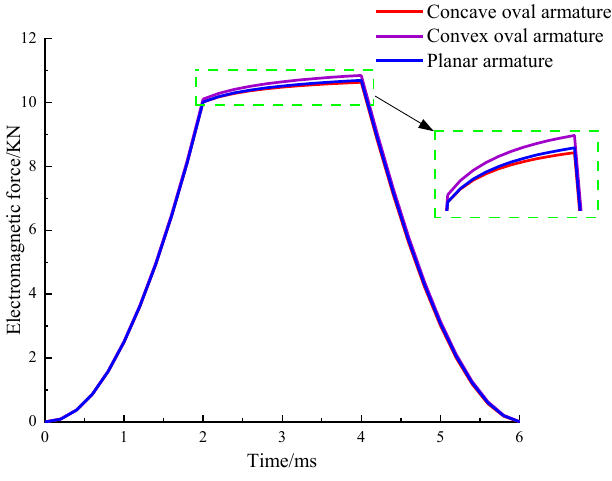
Figure 6. Electromagnetic thrust on the armature of the three